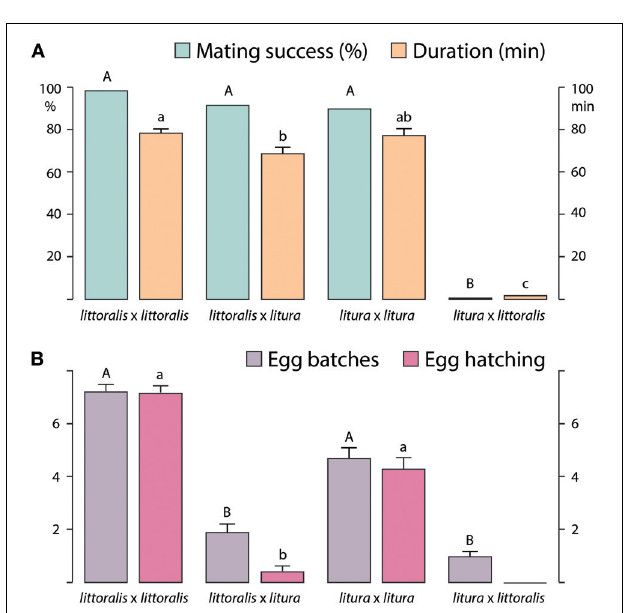
FIGURE 2 | (A) Successful conspecific and heterospecific Spodoptera littoralis and S. litura matings (%; n = 40 to 50, Chi-square test) and duration (min; n = 40 to 50, Kruskall-Wallis test). (B) Oviposition (mean number of egg batches per female) and larval hatching from egg batches, following conspecific and heterospecific matings (mean ± SE, n = 40 to 50, Mann-Whitney test). Matings shown as “female × male,” columns with different letters are significantly different at p < 0 .